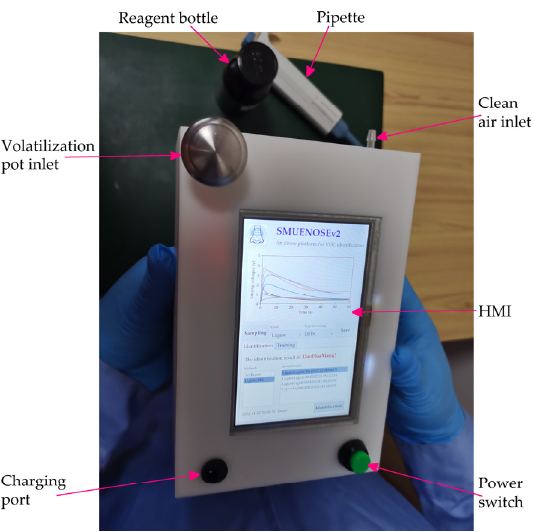
Figure 1. The scene of using SMUENOSEv2 for LVC identification.